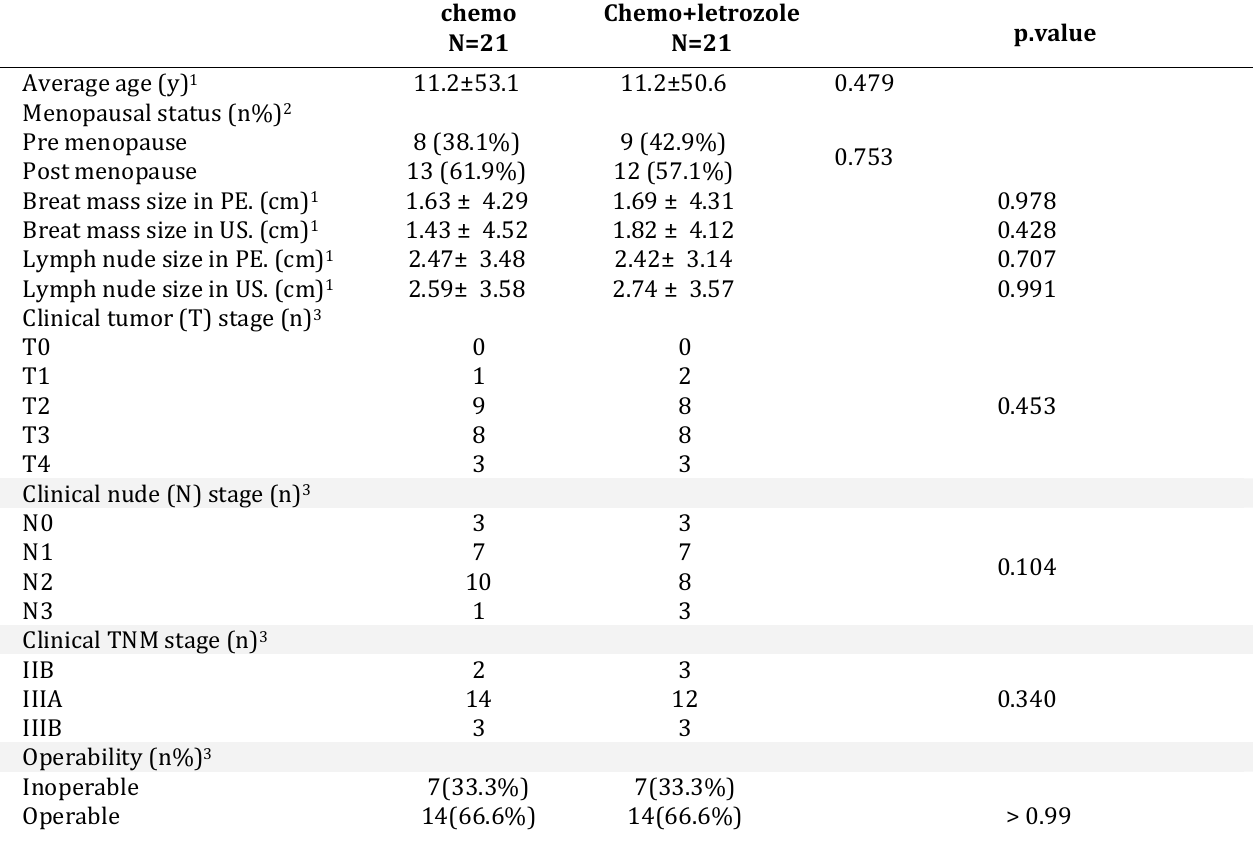
Table 1: Baseline charactrestics